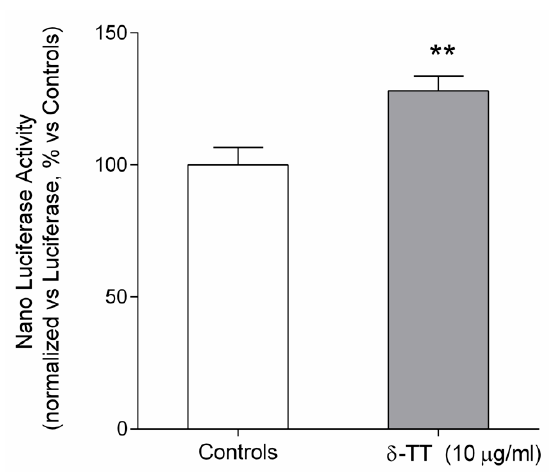
Figure 6. Involvement of β -catenin transcriptional activity in the e ff ect of δ -TT in MC3T3E1 cells transiently cotransfected with pGL4.54 (luc2TK) pNL (NLucP / TCF-LEF-RE) and treated for 48 h with δ -TT (10 µ g / mL). The ratio between Nano luciferase activity and luciferase activity (luminescence, arbitrary units) was expressed as percentage vs. controls. The data are presented as the mean ± SEM of eight replicates. ** p < 0.01 vs. controls.